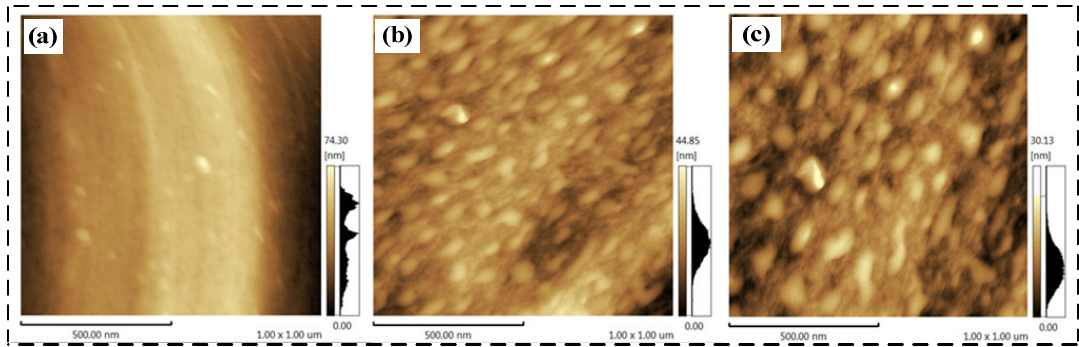
Figure 4. AFM photos of the samples under different treatment conditions: ( a ) Control; ( b ) Processed for 10 s; ( c ) Processed for 60 s.